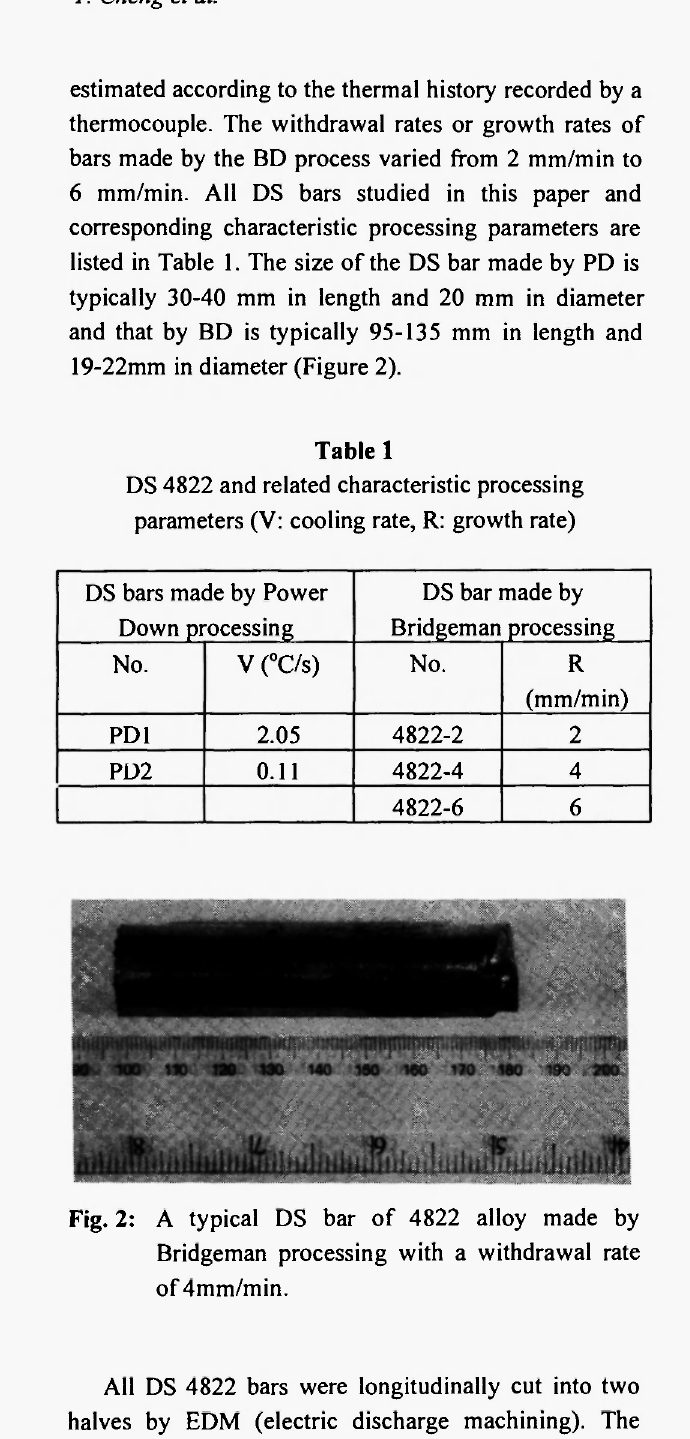
Fig. 2: A typical DS bar of 4822 alloy made by Bridgeman processing with a withdrawal rate of 4mm/min.